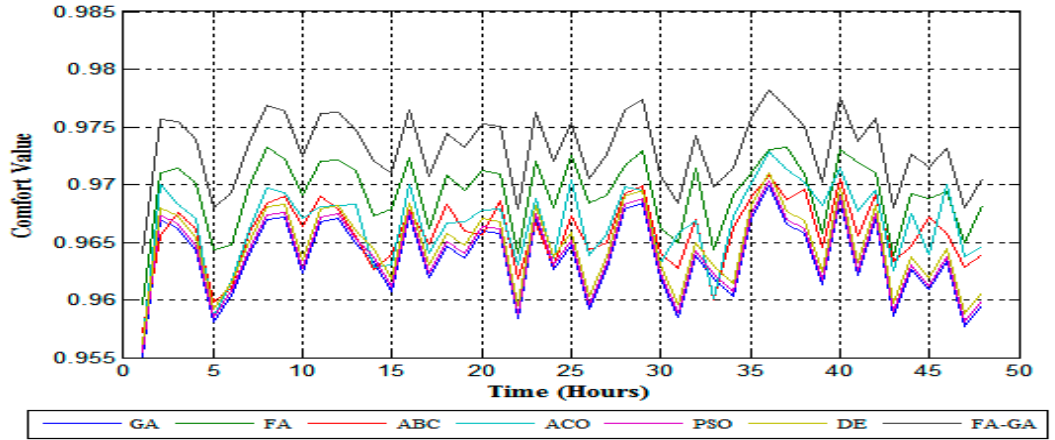
Figure 16. Comfort index calculated.